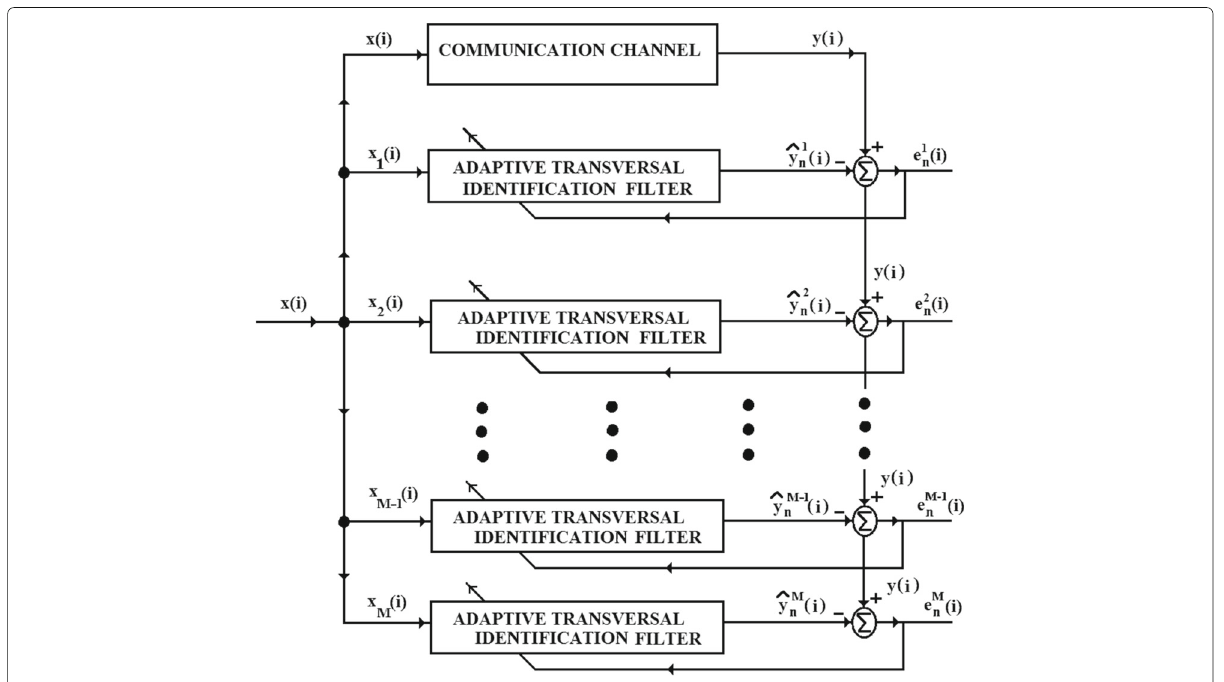
Fig. 1 A diagram of the multiple channel identification